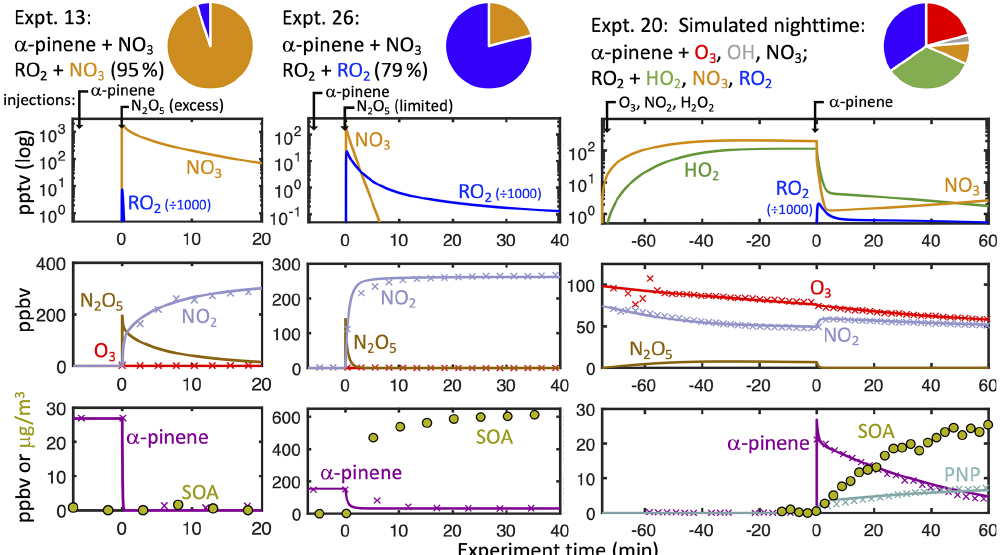
Figure 2. Modeled (solid lines) and measured (points) concentrations of key reactive species and products in three example chamber experi- ments. Timing of chamber injections is demarcated at the top. Experiment time of 0 corresponds to the beginning of α -pinene oxidation. Pie charts show the percent contribution of each α -pinene oxidative pathway ( α -pinene + O 3 in red, α -pinene + OH in grey and α -pinene + NO 3 speciated by subsequent RO 2 reaction partner: orange for NO 3 , blue for RO 2 , green for HO 2 ).